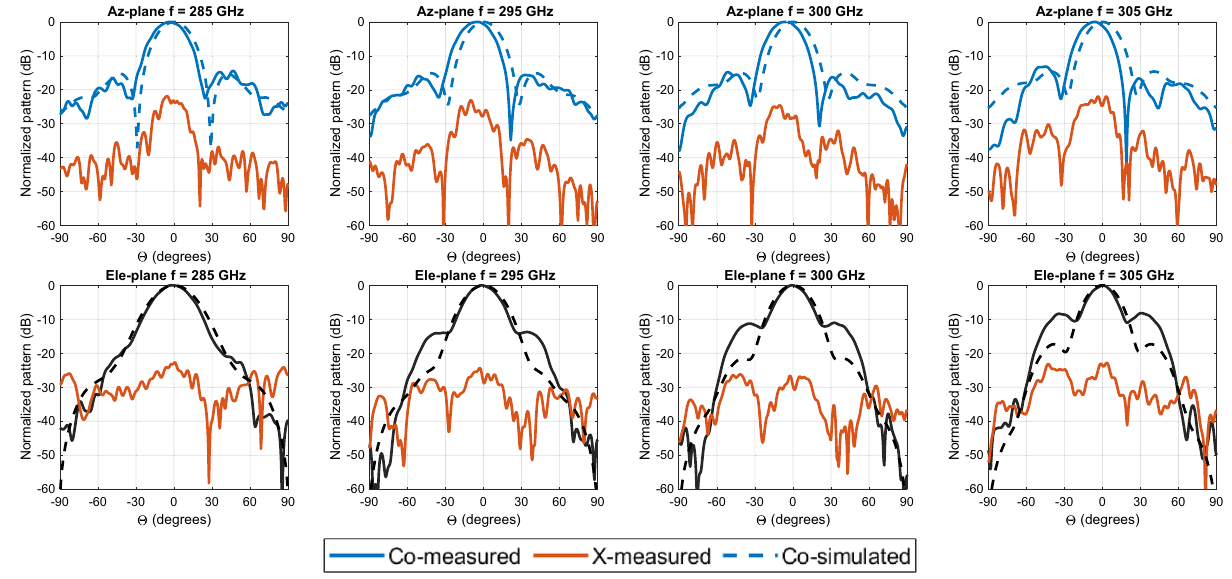
Figure 8. Measured (solid lines) and simulated (dashed lines) normalized radiation patterns of the proposed antenna of the azimuth (Az.) and elevation (Ele.) planes at different